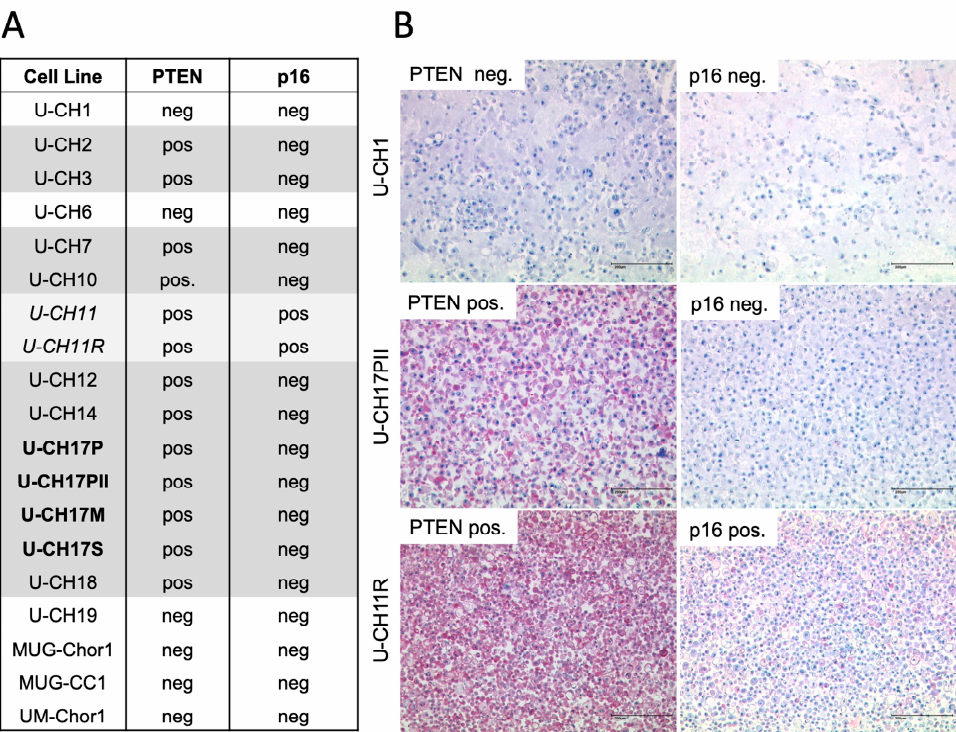
Figure 1. Immunocytochemical analysis of PTEN and p16 in chordoma cell lines. ( A ) Overview of the included cell lines with the respective PTEN and p16 statuses. ( B ) Immunocytochemical staining of PTEN and p16 in chordoma cell lines (scale bar = 200 µm). U-CH1 is PTEN- and p16-negative, whereas U-CH17PII is PTEN-negative and p16-positive. U-CH11R is positive for PTEN and p16.